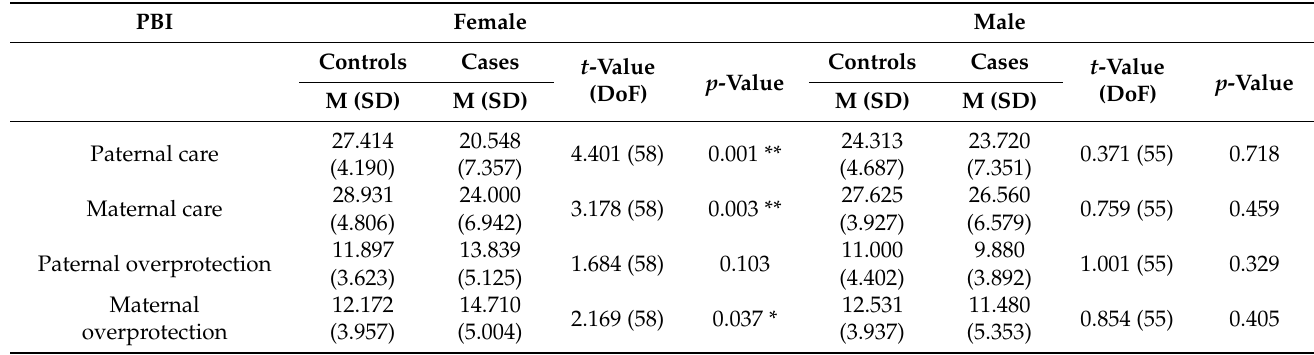
Table 3. The t -test female/male controls vs. cases.